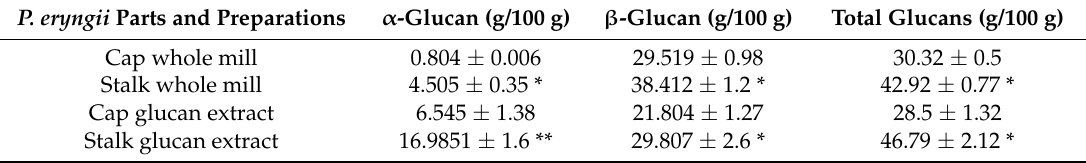
Table 1. Glucan content in cap and stalks from P. eryngii mill and glucan extracts. α , β , and total glucan concentrations (g/100 g dried matter) in mills and glucan extracts prepared from cap and stalks harvested from P. eryngii mushrooms. * p < 0.001, ** p < 0.0001 comparison between caps to respective